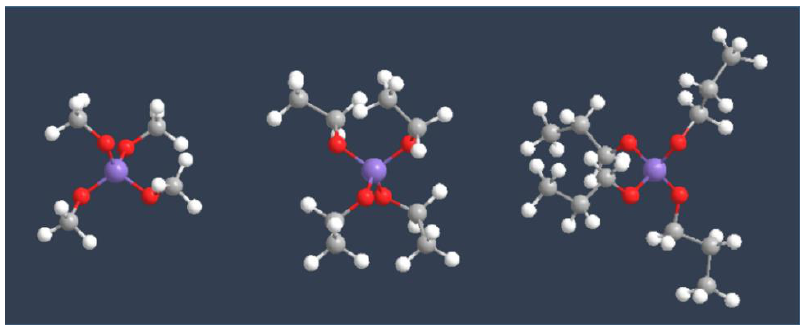
Figure 12. Ball and stick representation of tetramethyl ortosilicate (TMOS), tetraethyl orthosilicate (TEOS) and tetrapropyl orthosilicate (TPOS).